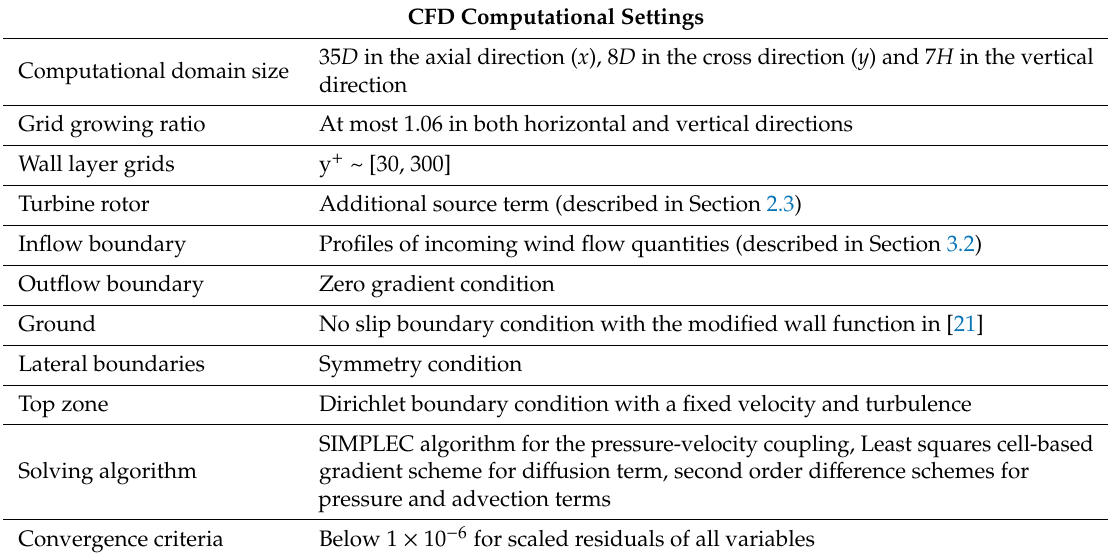
Figure 1. ( a ) Computational domain with its main boundary conditions and ( b ) computational mesh in the vicinity of the turbine rotor. Table 1. Summary of computational set-up in the computational fluid dynamics (CFD) models.